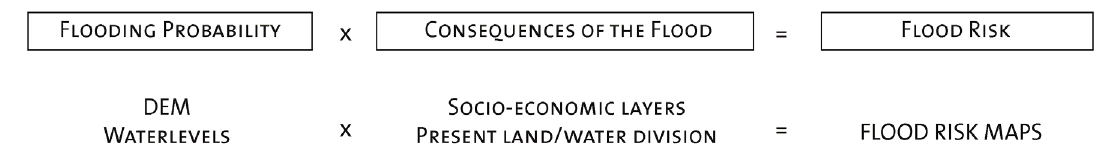
Figure 2. Conceptual risk